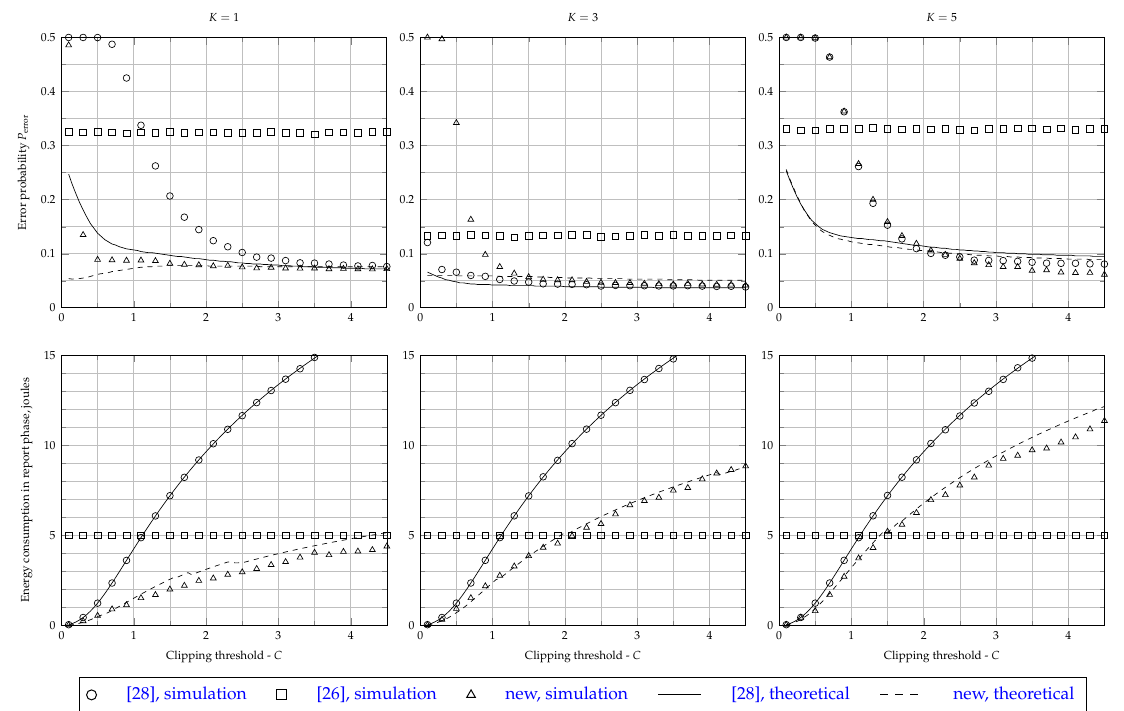
Figure 5. Error probability (top) and energy consumption (bottom) as a function of the clipping threshold C , for M = 5, γ SU = − 5 dB, γ FC = 5 dB and E = ξ = 1.